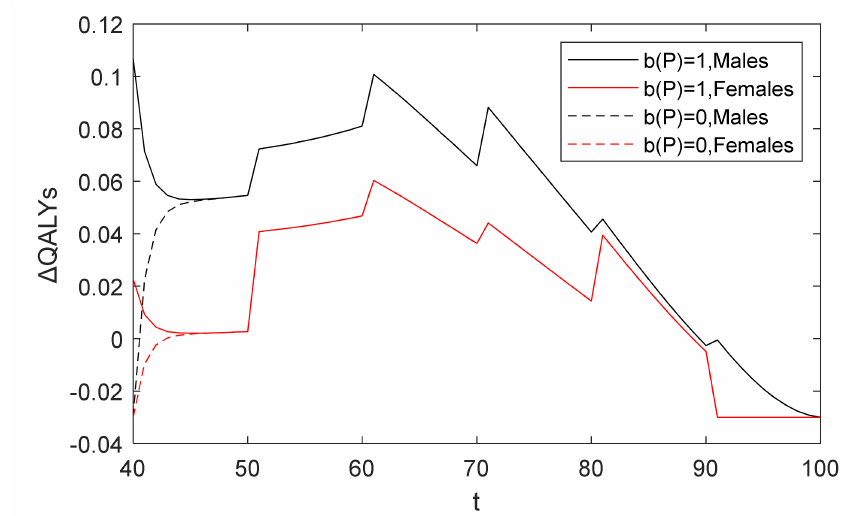
Figure 6. ∆ QALYs affected by individual characteristics.